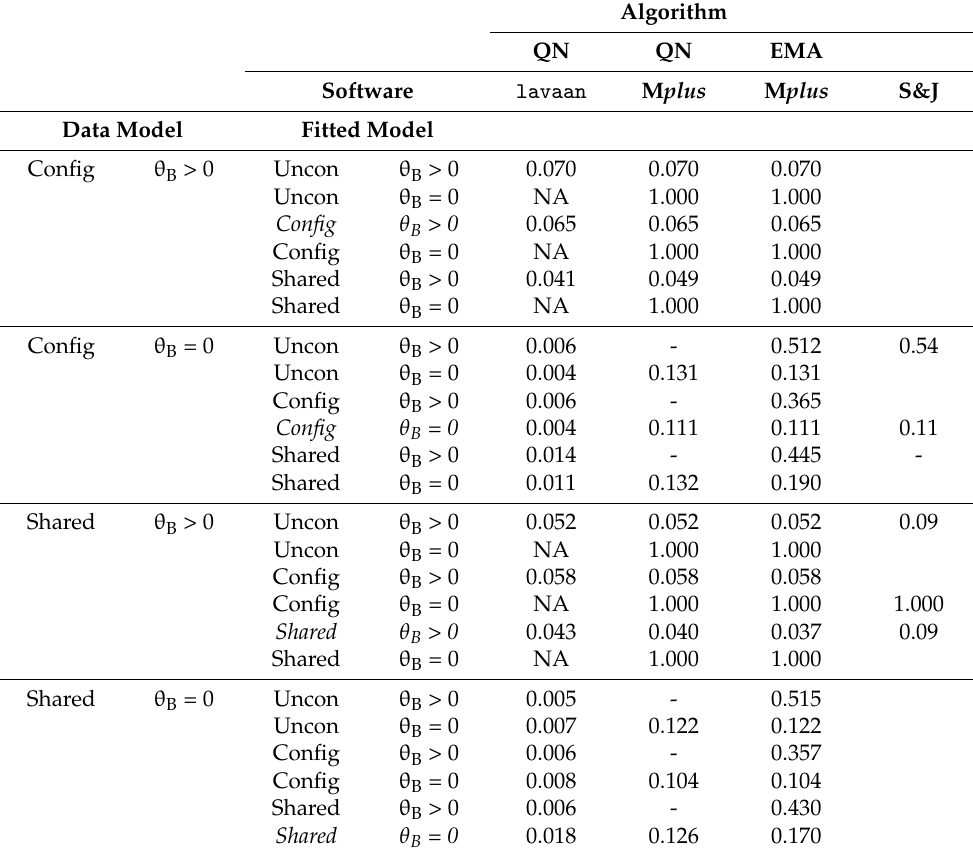
Table 6. Rejection rates of scaled χ 2 statistic (MLR) with 100 clusters across estimation algorithms.